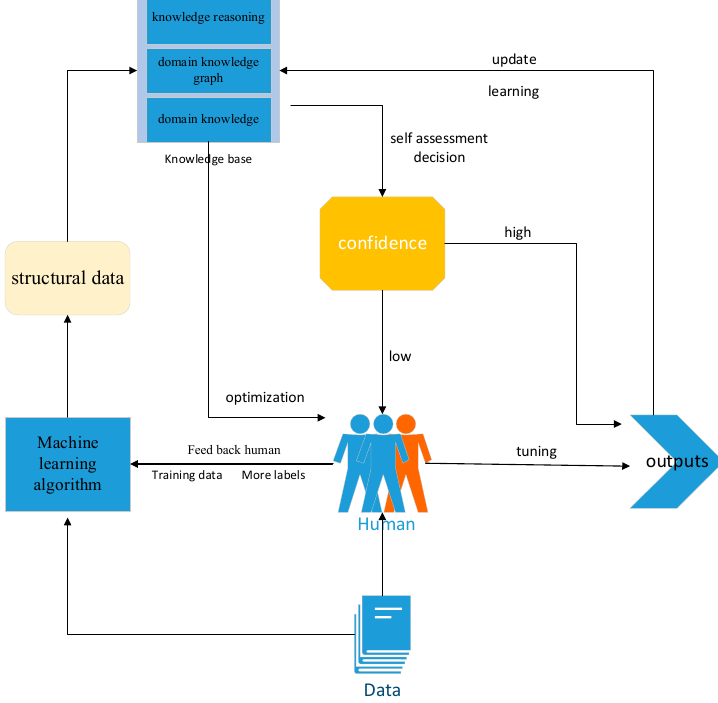
Figure 4. Base framework of human-in-the-loop (HITL) hybrid intelligence.